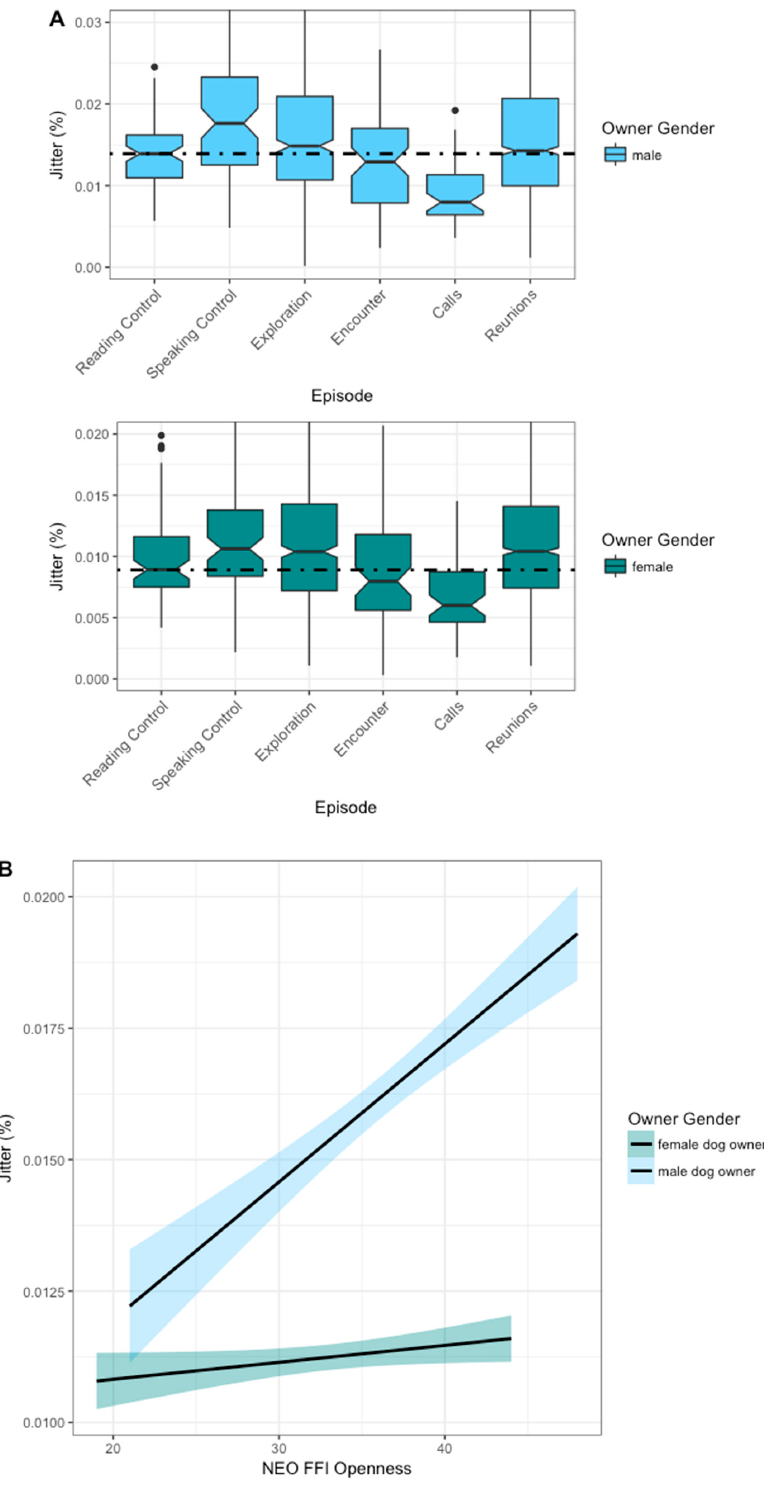
Figure 5. Percentage of jitter by gender over the dog owners’ NEO FFI character trait openness and throughout the ASSP. The light blue line represents male and the dark blue line represents female owner. ( A: Jitter plotted by gender over ASSP episodes with the dashed line representing the reading controls median. The two calls and reunions are visualized combined as “calls” and “reunions”. B: Jitter plotted by gender over the NEO FFI openness score.) n = 53; number of observations = 4121.